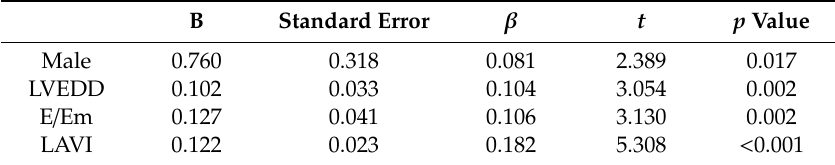
Table 2. Determinants of pulmonary vein volume index by multiple linear regression analysis.